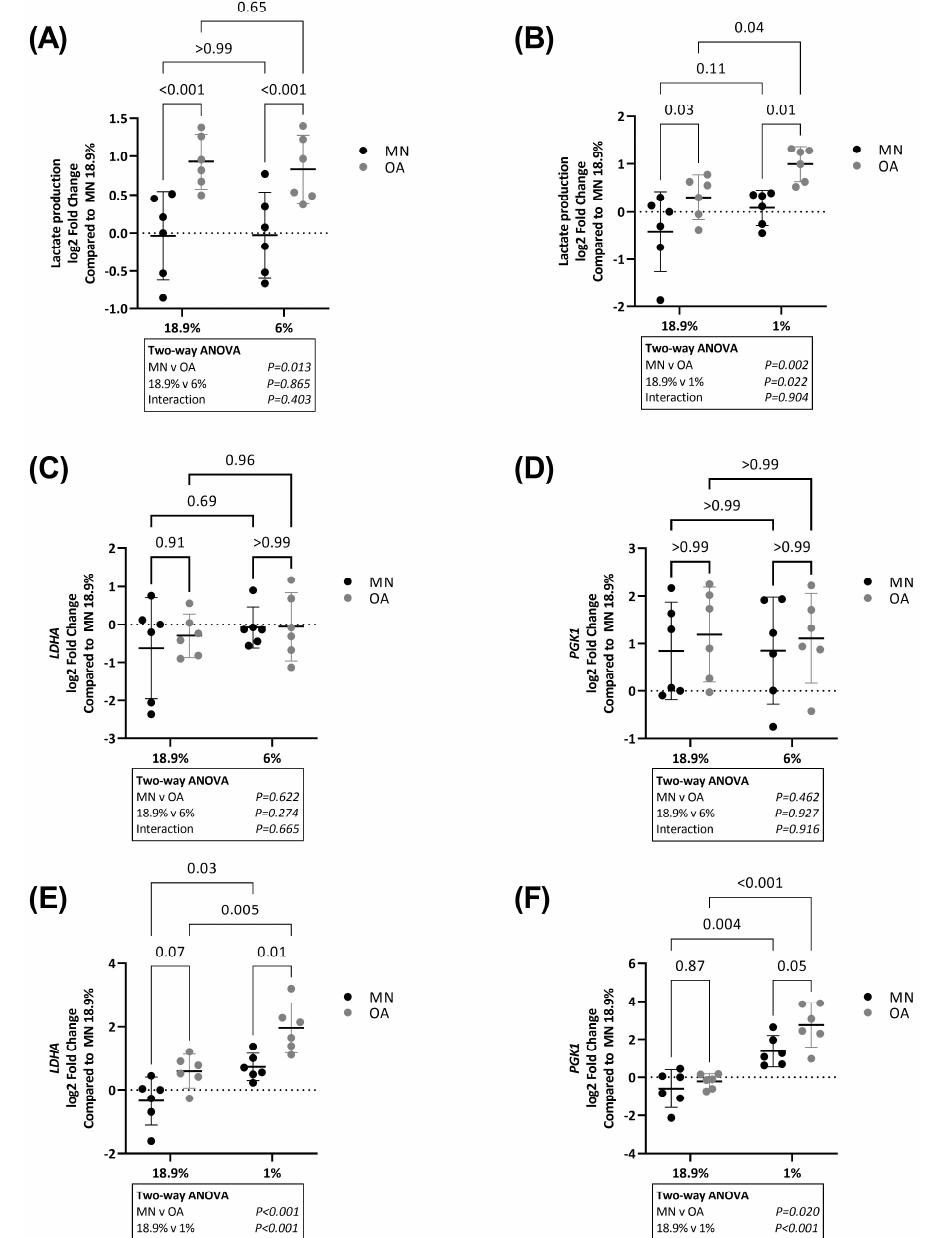
Figure 5. Lactate production and expression of the glycolytic genes LDHA and PGK1 in OA chondro- cytes and chondrocytes from macroscopically normal cartilage maintained in 18.9% compared to 6% or 1% oxygen. Paired samples of human chondrocytes isolated from macroscopically normal (MN) and osteoarthritic (OA) cartilage regions within OA joints from six patients were plated in duplicate plates. One plate was transferred to a standard tissue culture incubator (18.9% oxygen) and the other transferred to a hypoxia incubator maintained at either 6% or 1% oxygen for 24 h. Chondrocytes from a different six patients were used to compare the effects of 18.9% vs. 1% oxygen than those used to compare the effects of 18.9% vs. 6% oxygen. Comparison of lactate production in ( A ) cells maintained in 18.9% vs. 6% oxygen and ( B ) cells maintained in 18.9% vs. 1% oxygen. Comparison of RNA levels (measured by qPCR) of ( C ) LDHA and ( D ) PGK1 in cells maintained in 18.9% vs. 6% oxygen and ( E ) LDHA and ( F ) PGK1 in cells maintained in 18.9% vs. 1% oxygen. Data shown are mean ± 95% CI. All data were analysed by two-way ANOVA. Statistically significant differences between groups following post hoc testing are shown on graphs. p < 0.05 was considered statistically